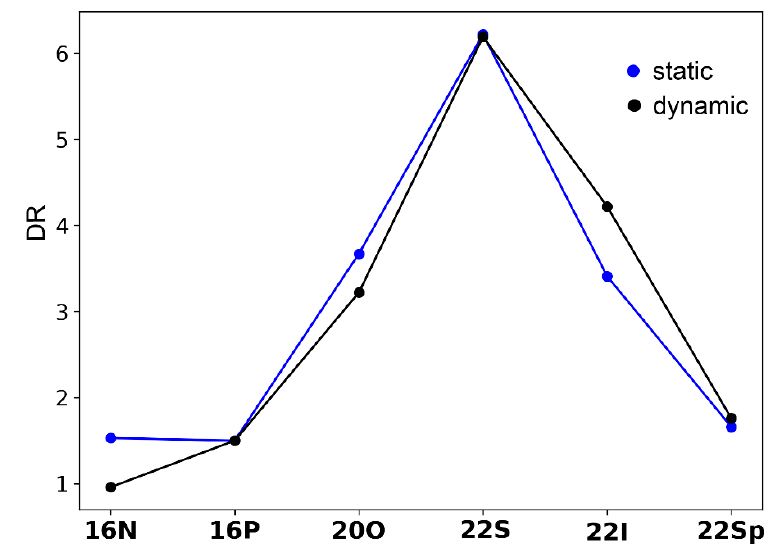
Figure 13. Evolution of the depolarization ratio (DR) in static and dynamic regime in solvent (2128 nm).